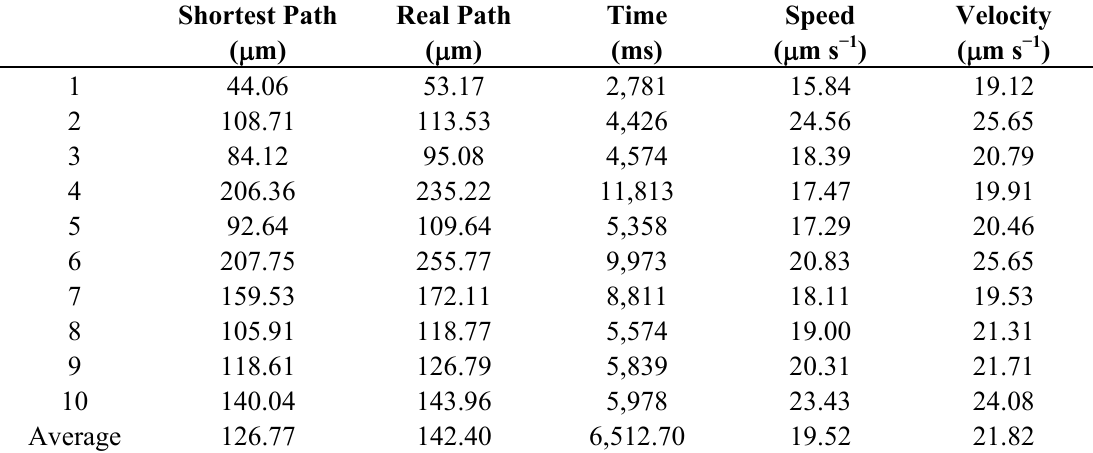
Table 6. Experiment data with both voltage and time as control